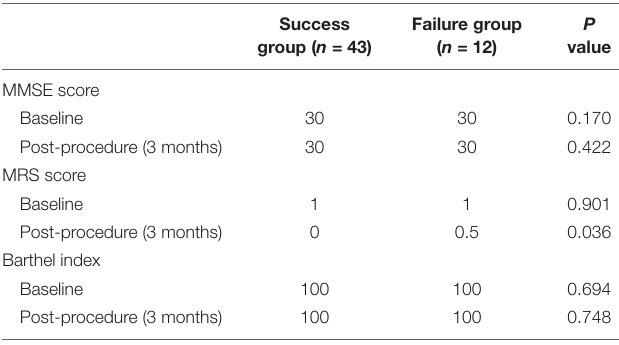
TABLE 4 | Neurocognitive and neurologic function among groups.